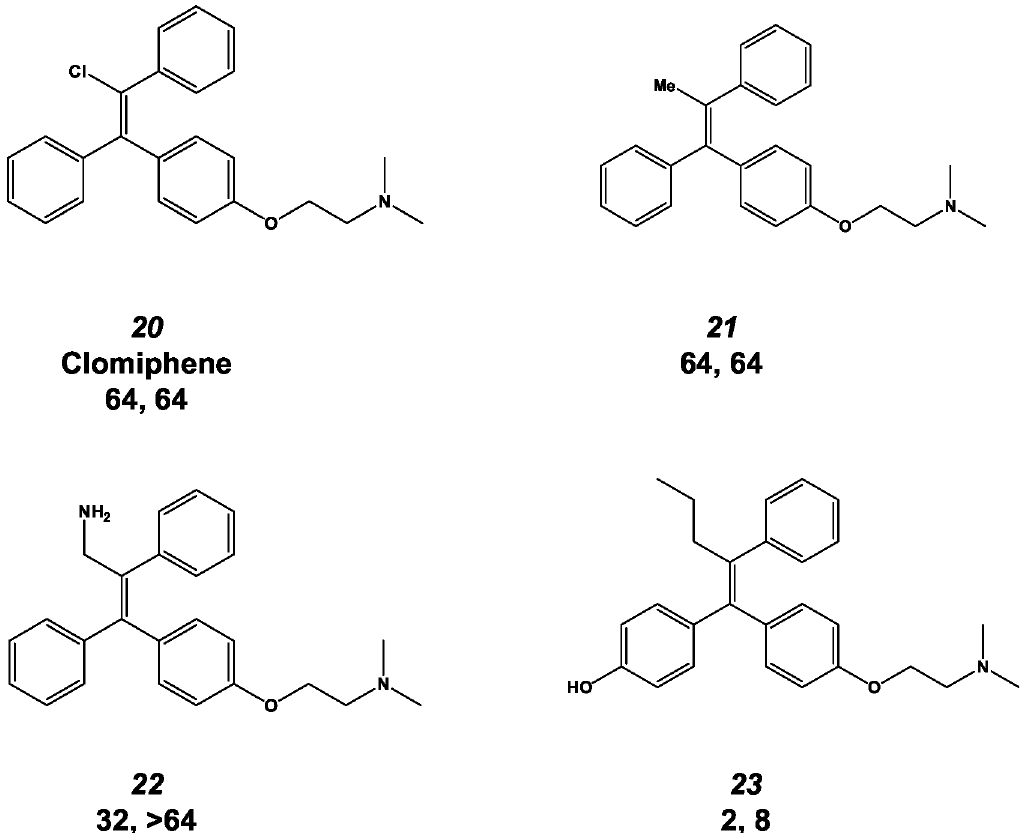
Fig 4. Antifungal activity of 2-ethenyl-substituted tamoxifen derivatives. The structure, molecule number used in the text, minimum inhibitory concentration (MIC, μ g/mL) against C . neoformans (first number) and MIC against C . albicans are provided.